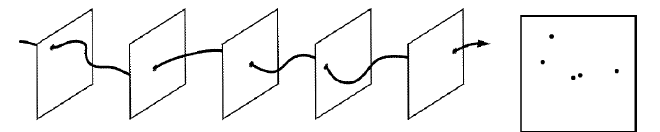
Figure 10. Schematic view of the Poincaré map.